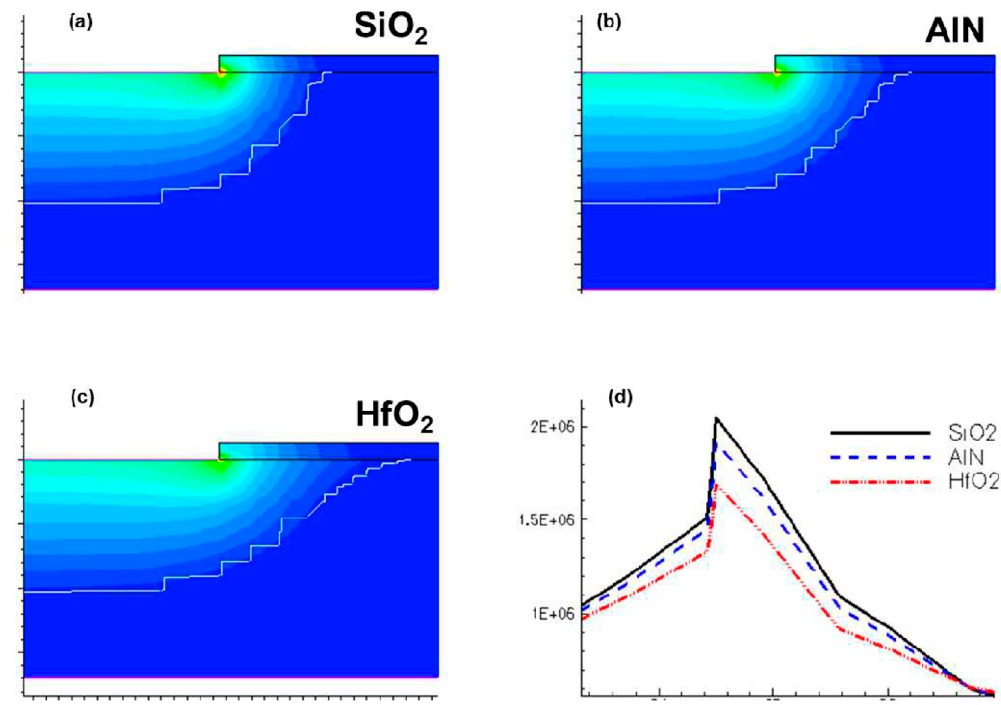
Figure 11. Cross-section electric field distribution of SiC Schottky diodes, including SiO 2 ( a ), AlN ( b ) and HfO 2 ( c ). On the right side ( d ), horizontal cut line of the electric field close to the passivation layer. Figure reproduced with permission from [49].